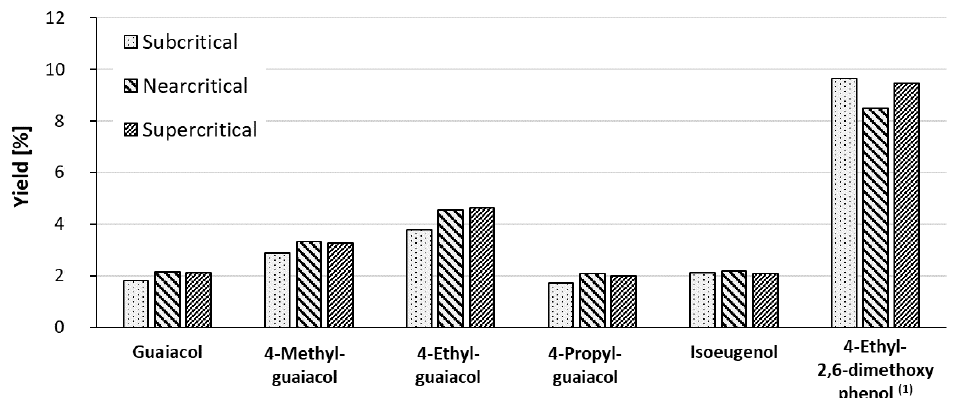
Figure 4. Mononuclear products observed for catalytic hydrogenolysis of kraft lignin in methanol with Ru/C at subcritical (200 °C, 76 bar, left ), near-critical (235 °C, 110 bar, middle ), and supercritical (250 °C, 131 bar, right ) conditions; (1) 4-ethyl-2,6-dimethoxyphenol or isomer.